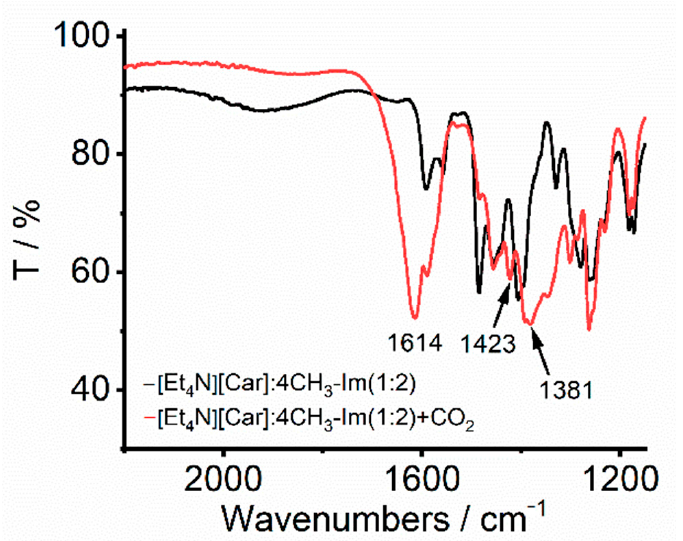
Figure 6. The FTIR spectra of [Et 4 N] [Car]:4CH 3 -Im (1:2) before and after CO 2 uptake.